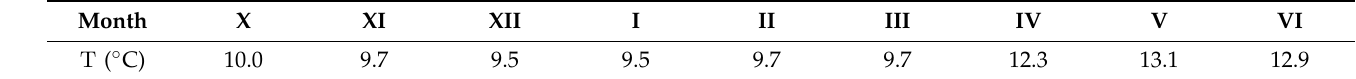
Table 3. Measured mean monthly fresh concrete mix temperatures T ( x,y , z , τ = 0) [ ◦ C].